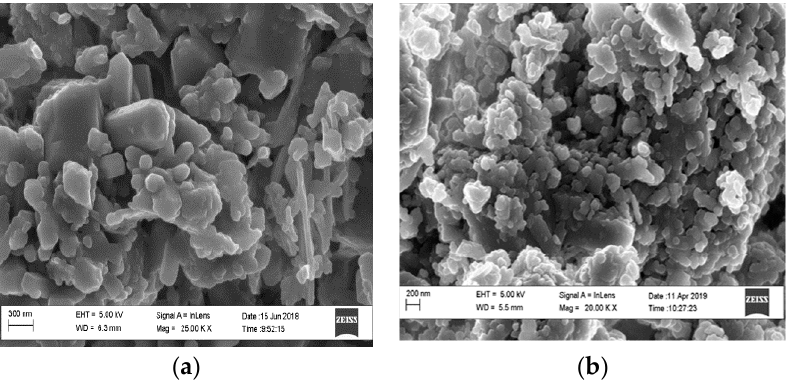
Table 1. Elemental composition showing the effect of ion exchange-modification on produced fu- sion-assisted hydrothermal HS zeolite.